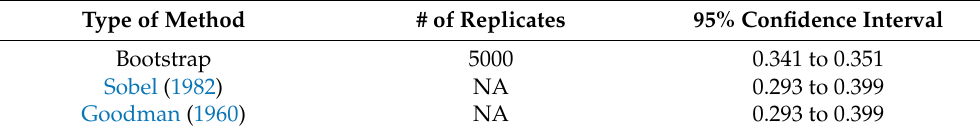
Table 4. Test of mediation effect.